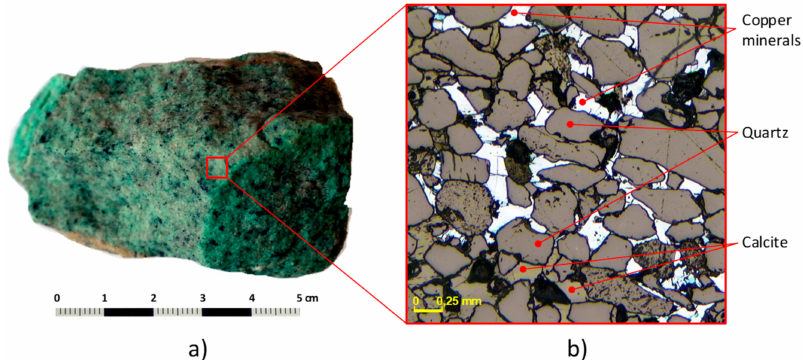
Figure 4. Copper ore (green sandstone ore): ( a ) hand specimen, ( b ) microphotograph under reflected